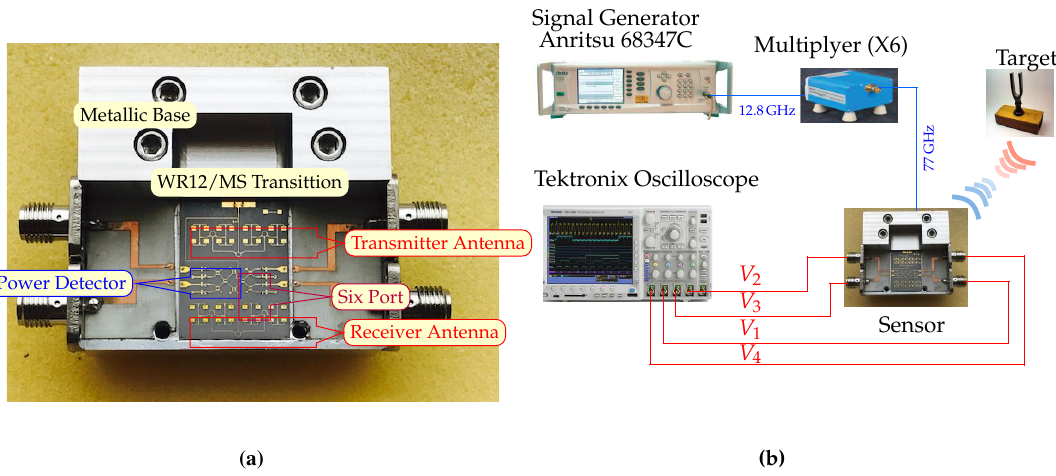
Figure 19. ( a ) Picture of the manufactured hardware prototype. ( b ) Short distance measurement setup. Figure 19. (a) Picture of the manufactured hardware prototype. (b) Short distance measurement set-up.